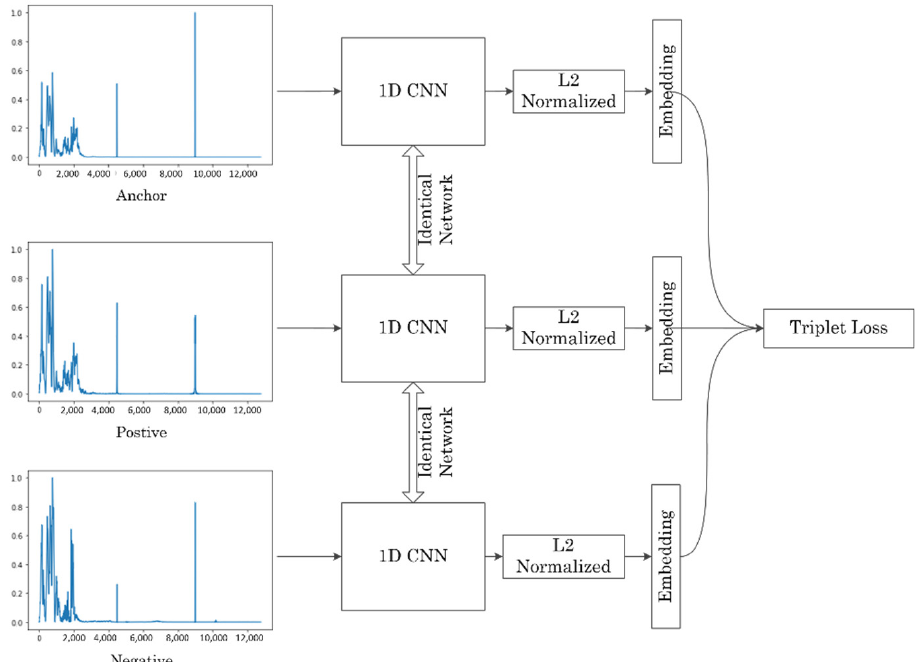
Figure 2. Triplet network architecture.